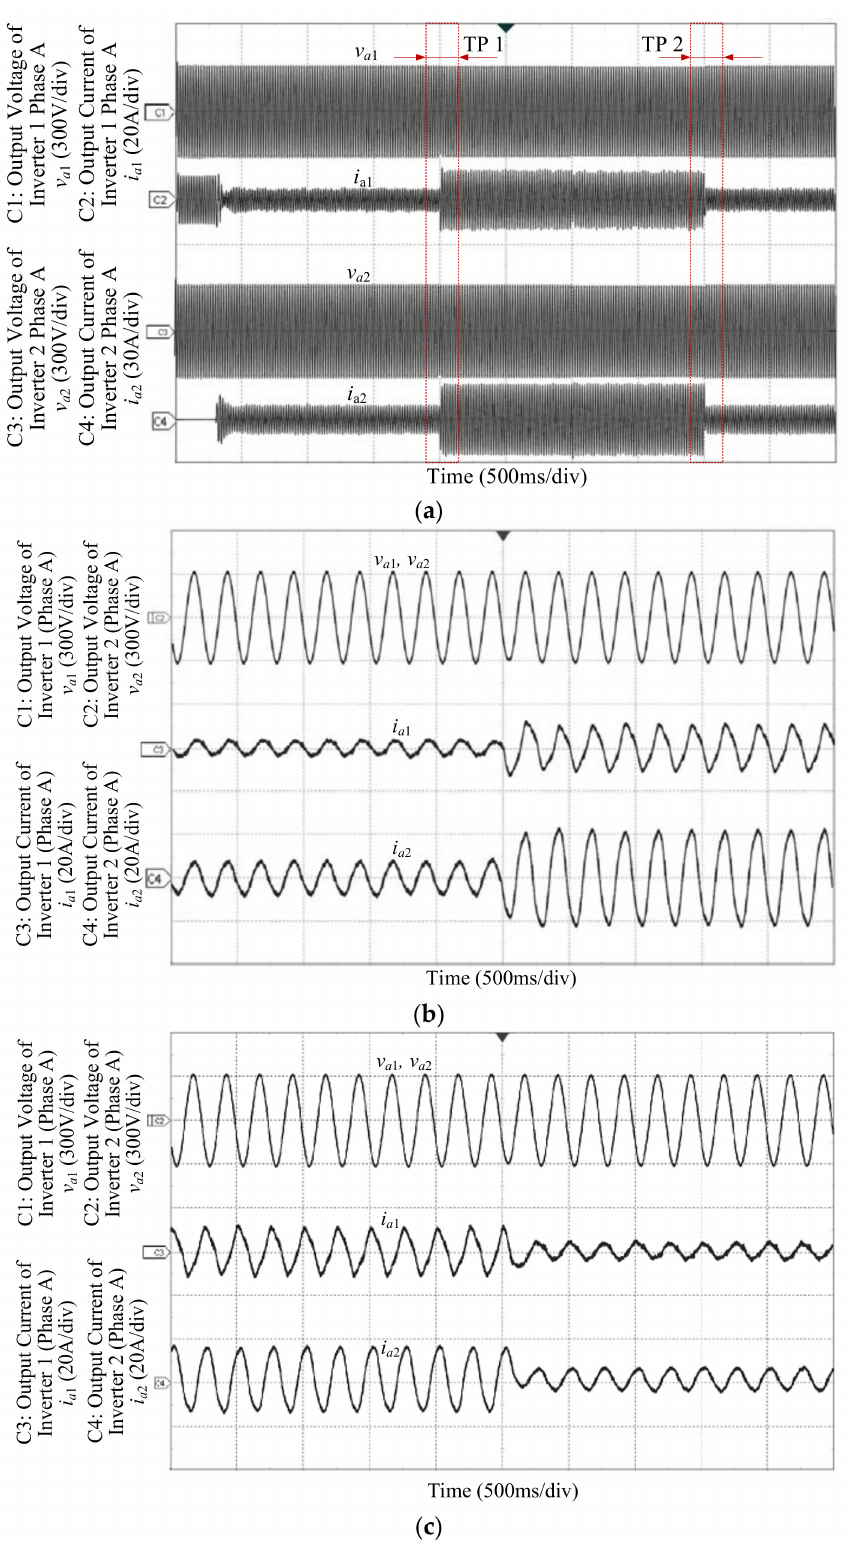
Figure 8. Output voltages and currents of the two DG inverters (Phase A). ( a ) waveforms captured in the whole events; ( b ) zoomed in waveforms in TP1; ( c ) zoomed in waveforms in